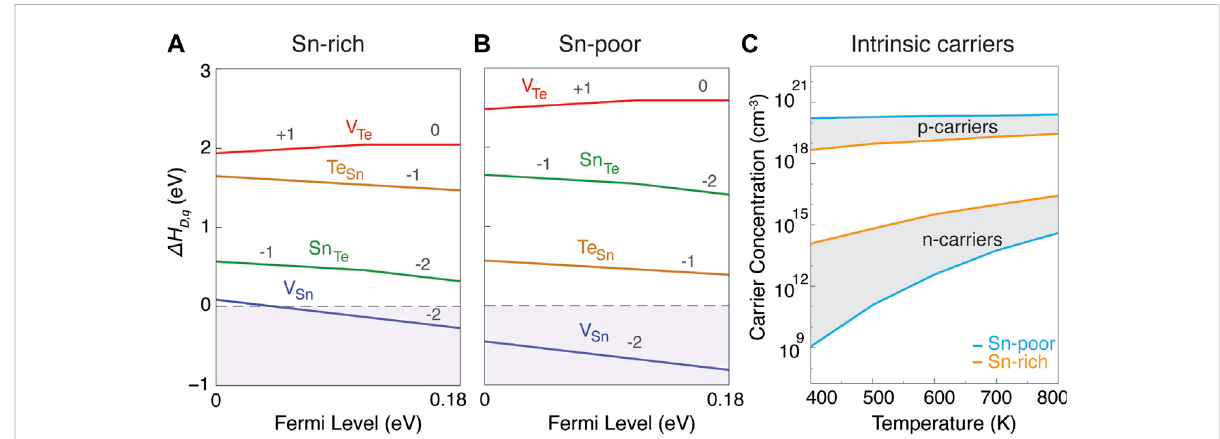
FIGURE 6 DefectformationenergyfornativepointdefectsasafunctionofFermilevel( E F )inSnTeunder (A) Sn-richand (B) Sn-poorgrowthconditions.In both growth conditions, V Sn is the dominant acceptor defect which pushes the Fermi level below the VBM and makes SnTe a degenerate p -type semiconductor. (C) Prediction of both hole and electron carrier concentrations as a function of temperature in Sn-rich and Sn-poor growth